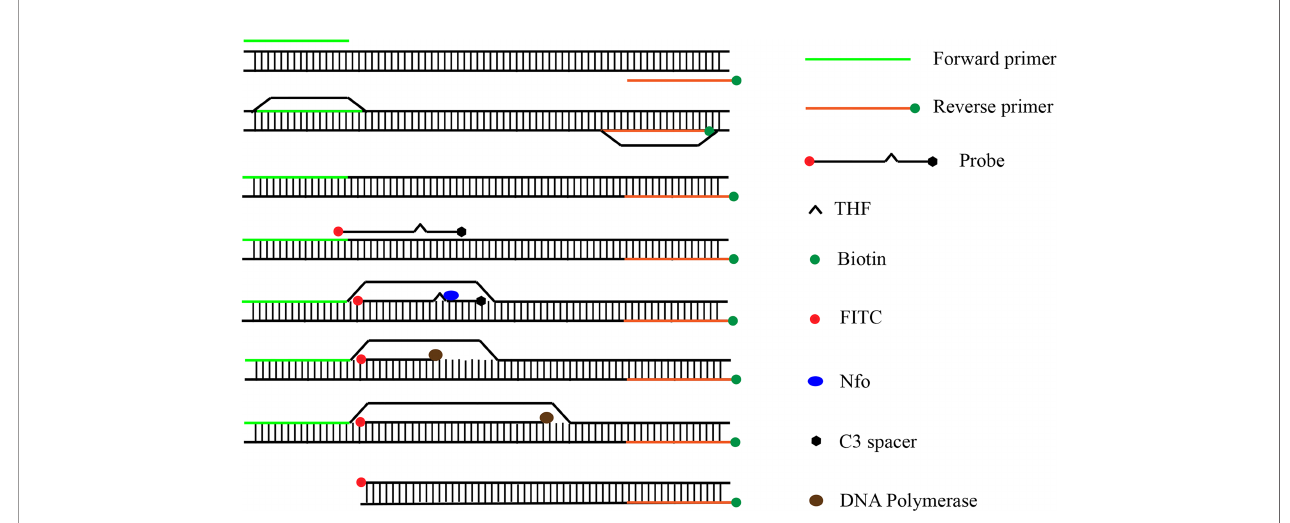
FIGURE 2 | Ampli fi cation principle of RPA-LFS. The shapes and their representative molecules are listed on the right side of the